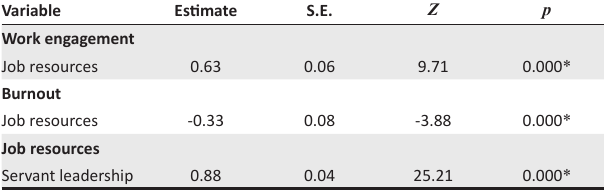
TABLE 5: Standardised regression coefficients of the latent